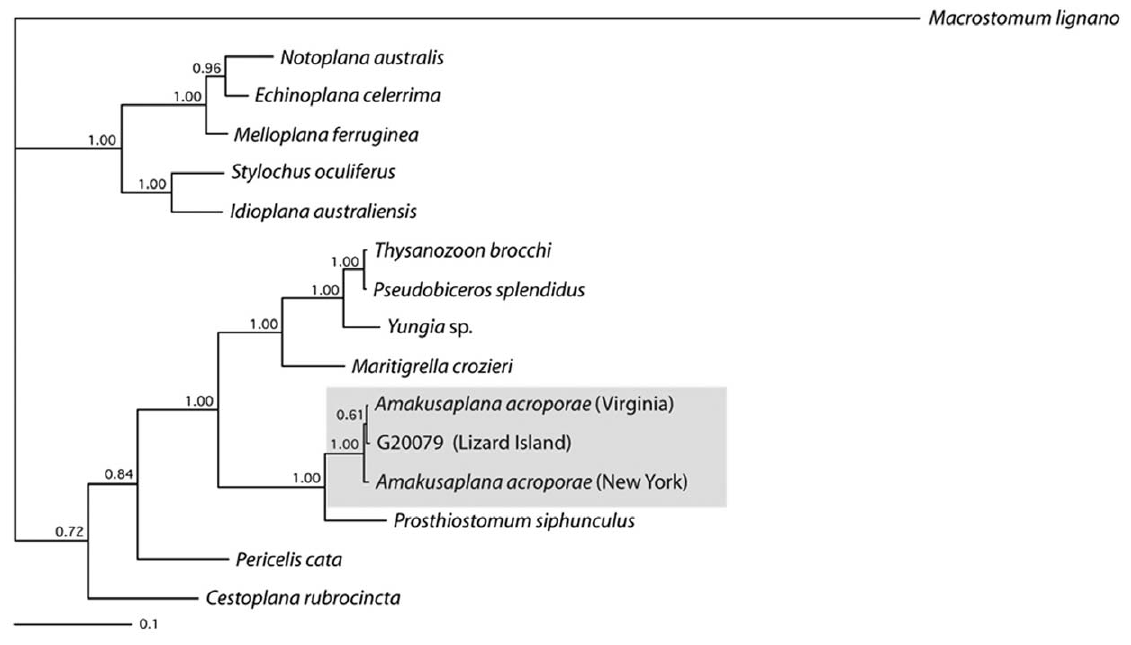
Figure 3. Consensus phylogenetic tree resulting from the Bayesian analysis of 28S rDNA sequence data. Clade support indicated by Bayesian posterior probabilities. The Lizard Island polyclad (G20079) falls out within a well–supported clade of Amakusaplana acroporae from captivity.